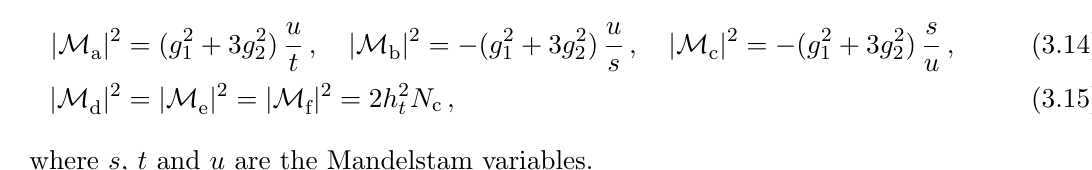
Figure 3 . The phase space regions contributing to eq. (3.16). Here ( q; q four-momentum of the exchanged particle. There are logarithmic infrared divergences associated with the fermionic contributions (cid:8) s f and (cid:8) t f , from soft lepton exchange (exchanged particle has ( q; q ) (cid:25) (0 ; 0)) and soft Higgs scattering (exchanged particle has ( q; q 0 scatterer is soft). The divergences can be resummed as explained in sections 3.4 and 3.5,